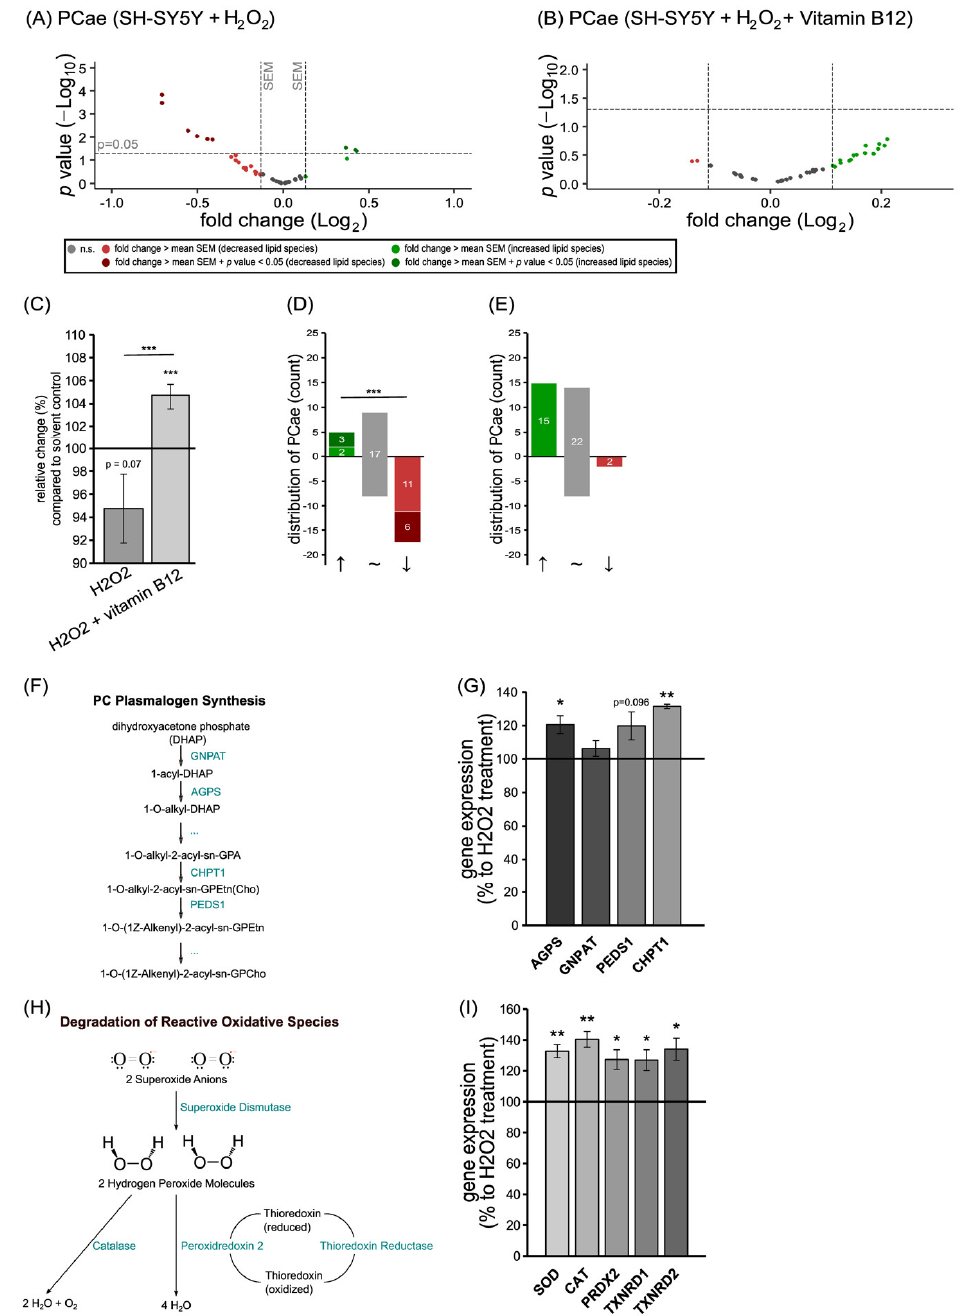
Figure 5. Comparison of the effect of vitamin B12 treatment on phosphatidylcholine plasmalogens (PCae) species in the presence of hydrogen peroxide. SH-SY5Y cells treated with a combination of hydrogen peroxide and vitamin B12, compared to cells treated with hydrogen alone. ( A , B ) In each of the volcano plots, each PCae species with its fold change (x-axis) in relation to its p -value (y-axis) is shown as a dot. Plots are structured as in Figure 1. ( C ) The bar chart shows the relative fold change of the PCae species after H 2 O 2 treatment alone or H 2 O 2 treatment in combination with vitamin B12, in comparison to treatment with the solvent control. ( D , E ) Distribution of the PCae species after H 2 O 2 treatment alone ( D ) or H 2 O 2 and vitamin B12 treatment ( E ) is shown, structured according to the amount of increased, unchanged, or decreased species. ( F ) Schematic representa- tion of plasmalogen synthesis. ( G ) Expression analysis of genes involved in plasmalogen synthe- sis using qPCR, comparing combined H 2 O 2 and vitamin B12 treatment to H 2 O 2 treatment alone. ( H ) Schematic representation of H 2 O 2 elimination. ( I ) Expression analysis of genes involved in H 2 O 2 elimination using qPCR, comparing combined H 2 O 2 and vitamin B12 treatment to H 2 O 2 treatment alone. Statistical significance was set as * p ≤ 0.05, ** p ≤ 0.01 and *** p ≤